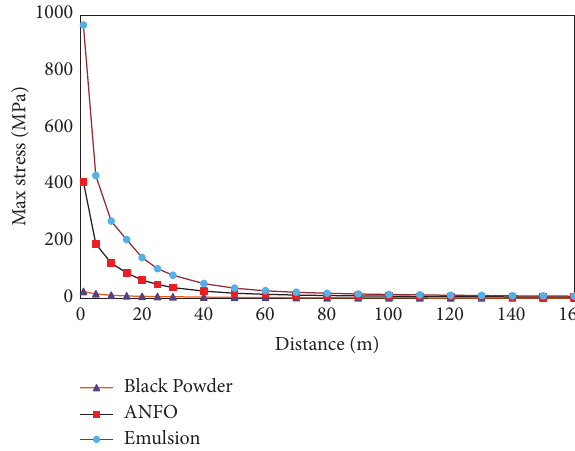
Figure 13: The relationship between maximum stress and distance for different types of explosives.